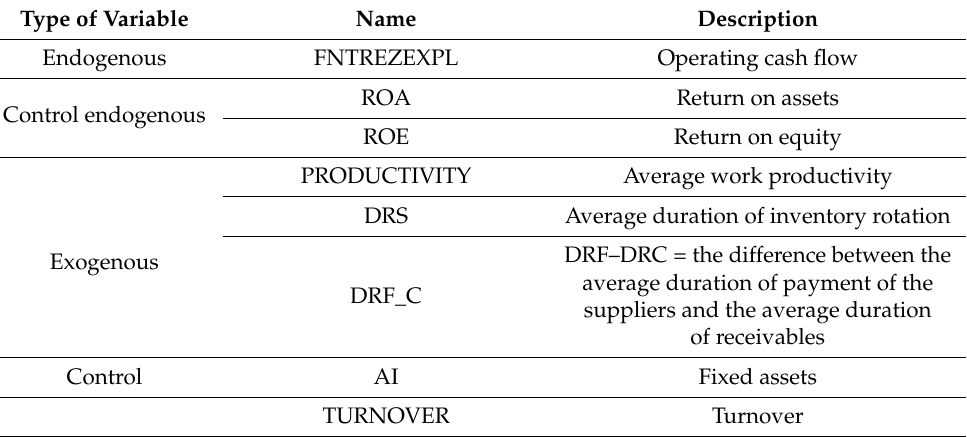
Table 1. Variables considered in the